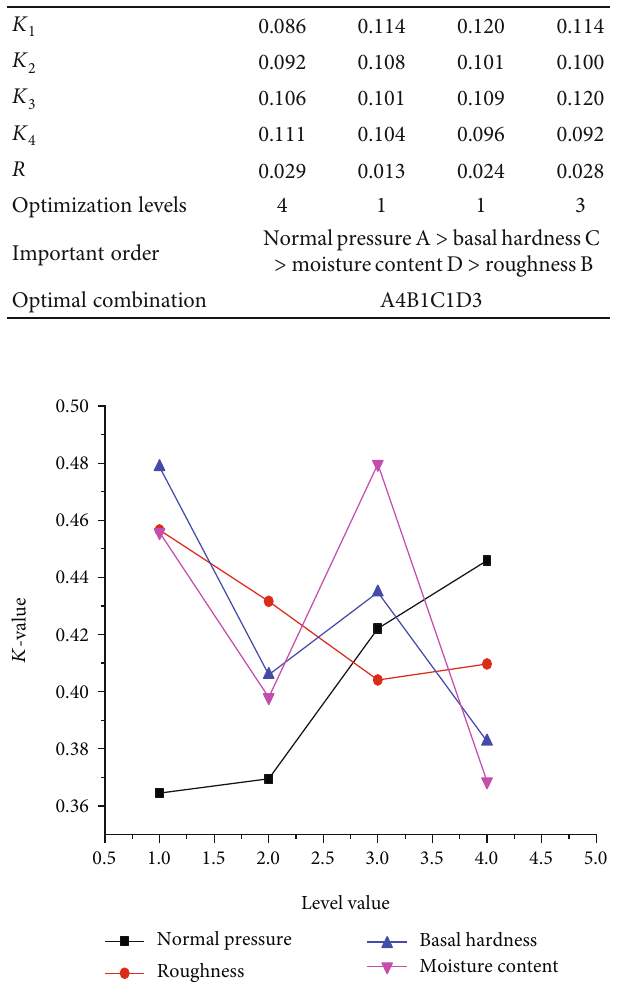
Figure 10: Relationship between particle crushing rate and in fl uencing